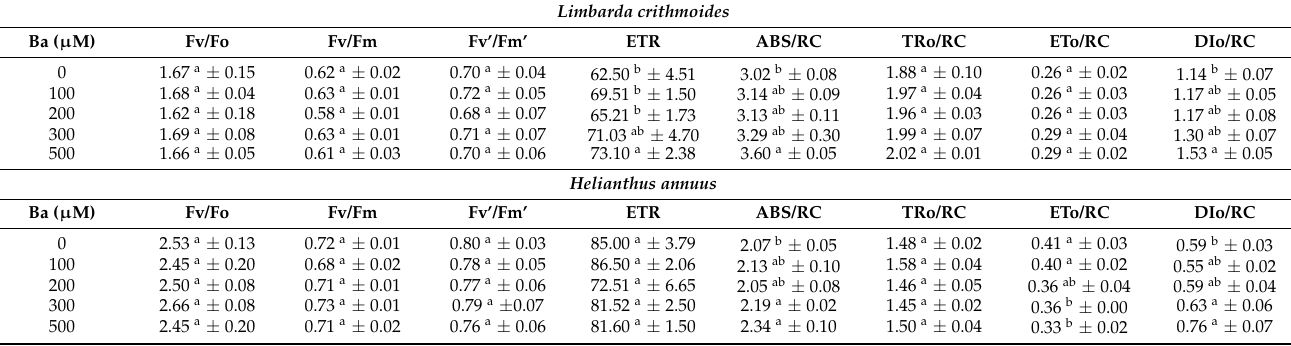
Table 2. Chlorophyll fluorescence parameters of Limbarda crithmoides and Helianthus annuus under the effect of different Ba concentrations after 45 days of the treatment. Data are shown as means ± SD; values with lower-case denote significant differences at p < 0.05. Fv/Fo: maximum primary yield of photochemistry of Photosystem II, Fv/Fm: maximum quantum efficiency of Photosystem II, Fv’/Fm’: photochemical efficiency of Photosystem II, ETR: electron transport rate, ABS/RC: absorption